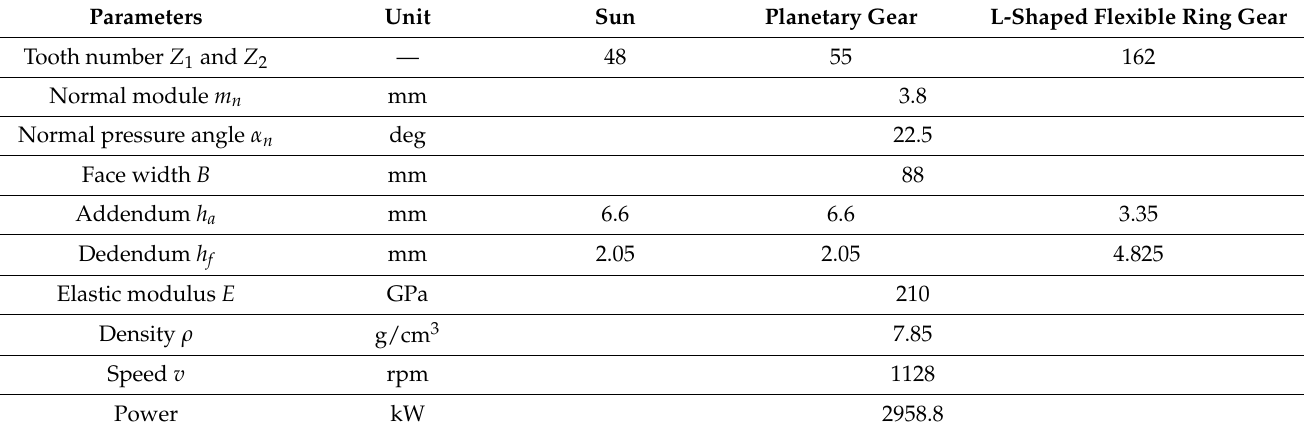
Table 1. Basic parameters of the L-shaped flexible ring gear planetary transmission